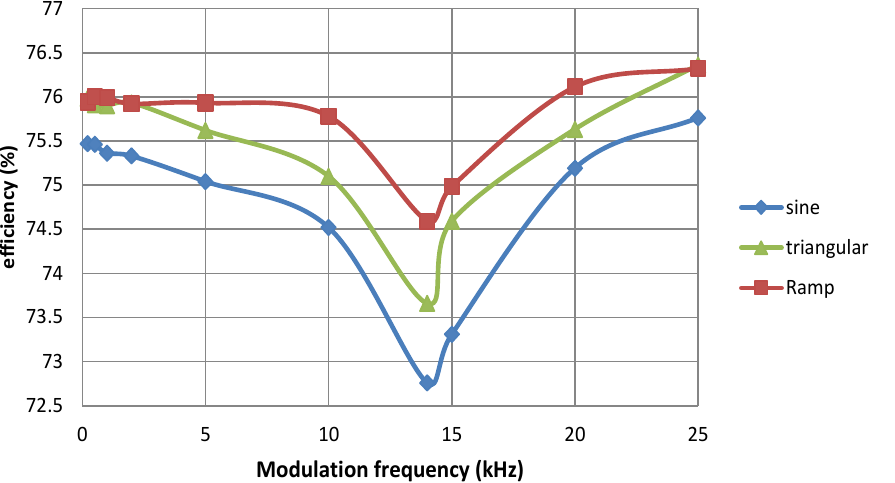
Figure 15. Measured efficiency versus f m when periodic SFM (with different modulation waveforms